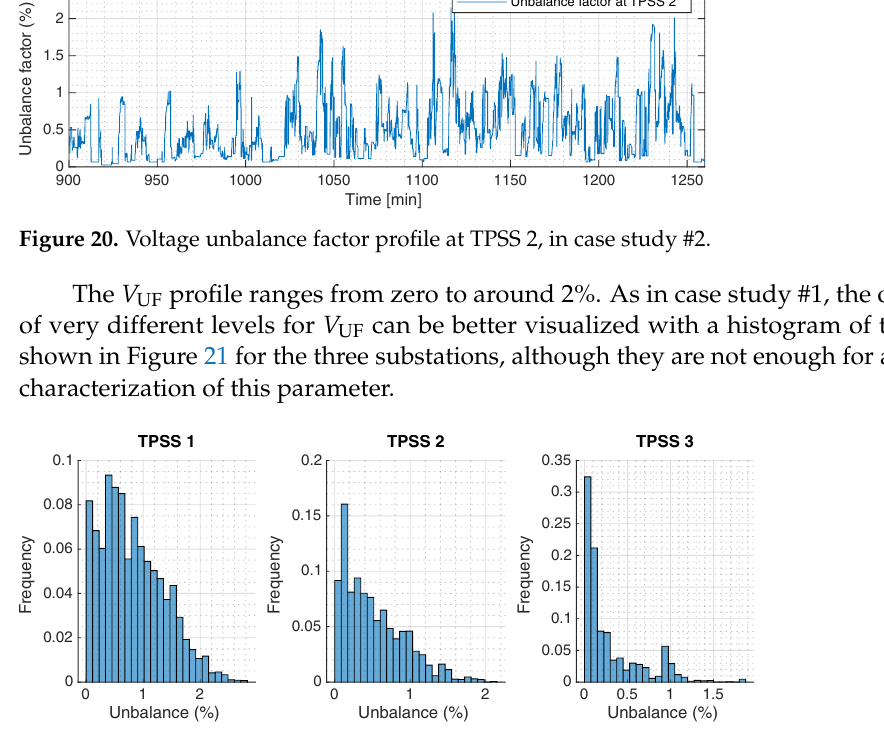
Figure 21. Histogram of V UF for the three substations constituting the line in case study #2. Substation #3 appears to have a better interface to the electric grid in terms of power quality while substations #1 and #2 might require further attention in terms of monitoring. The time period selected to analyze the power factor and the power losses in the three-phase grid is from 17:20 to 17:50 (1040 min–1070 min). The power factor evaluation is shown in Figure